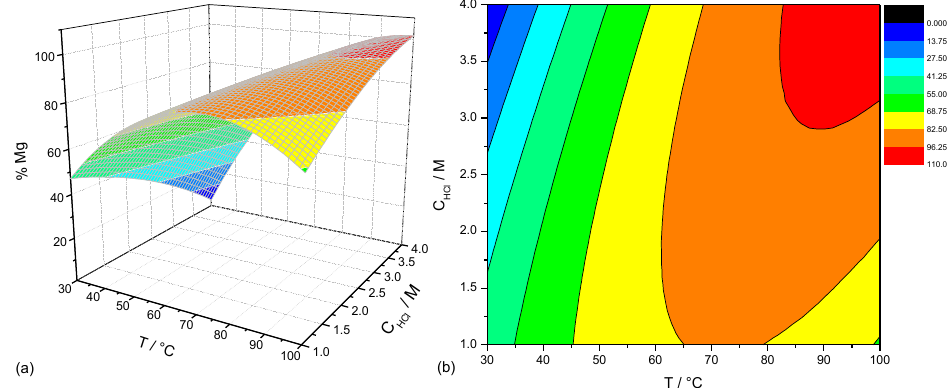
Figure 3. ( a ) Response surface and ( b ) contour lines of the Mg extraction process.